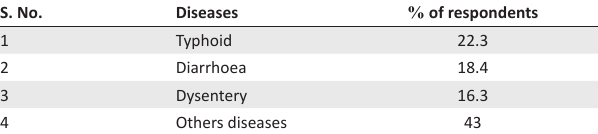
FIGURE 2: Borehole construction